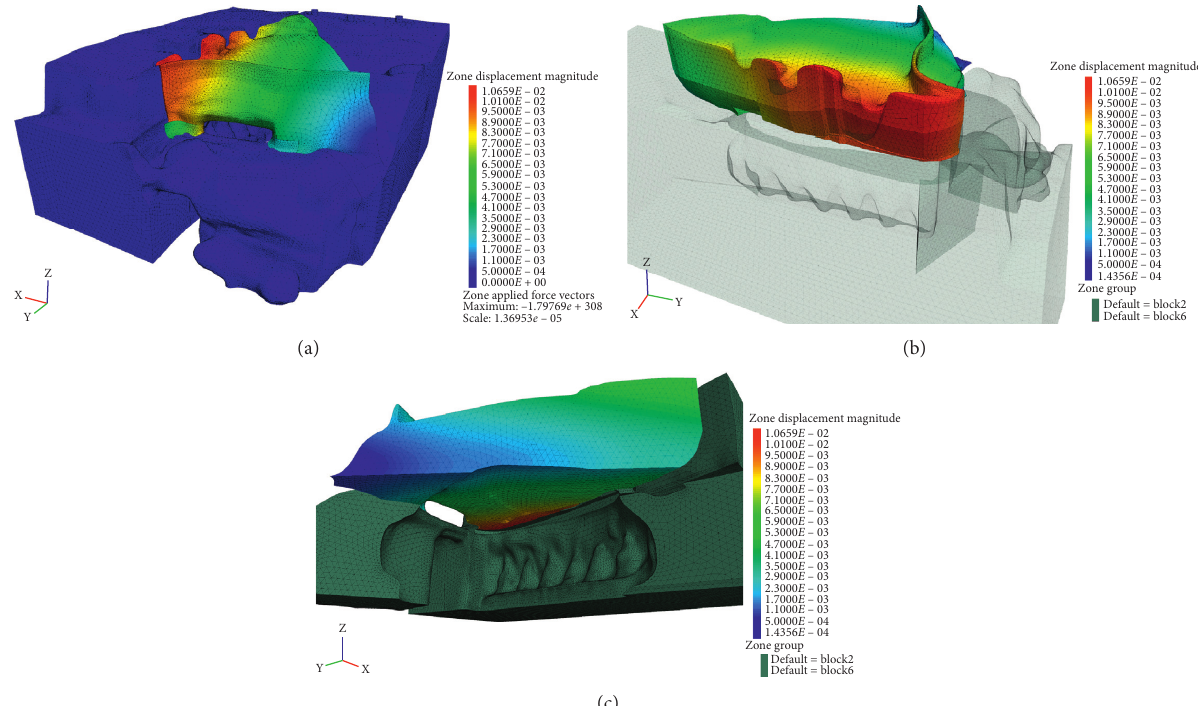
Figure 15: Displacement nephogram of Yuanjue Cave local model. (a) Nephogram of total displacement, (b) displacement of roof (perspective 1), and (c) displacement of roof (perspective